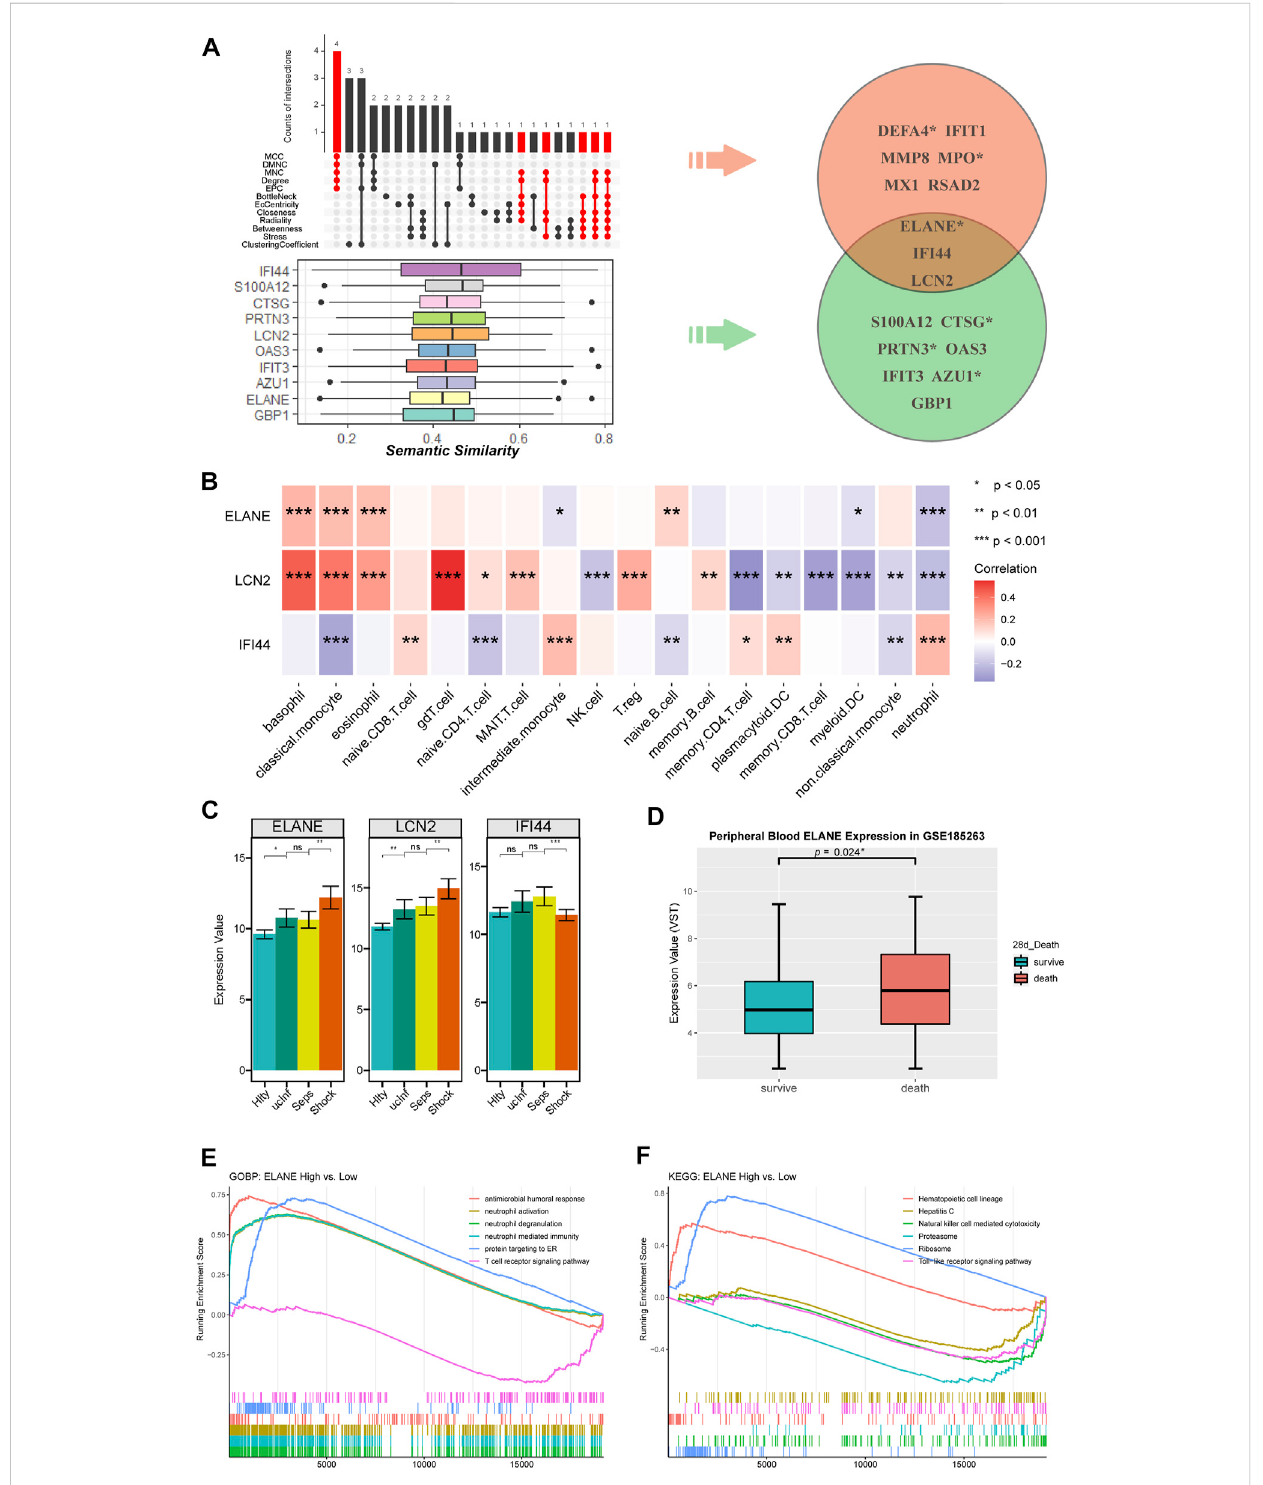
Theidenti fi cationofhubgenesinSSAGs. (A) Thegenesappearingatleast5timesintop10resultsofeachalgorithmusingcytoHubbawereextracted (marked in red) and shown in the upset plot, below the SSAGs with top 10 functional similarities estimated by Semantic similarity analysis were shown in boxplots.Threegeneswereidenti fi edashubgenesbyoverlappingthetworesults.Thegenenamesmarkedwithanasteriskindicatedthemasprognostic genes. (B) Correlations between hub genes and immune cell fractions. (C) Expression values of hub genes among the course from healthy to septic shock. (D) ELANEwassigni fi cantlyupregulatedindeath(n=52)vs.survival(n=293)groupoftheGSE185263dataset. (E) Biologicalprocessesenrichedin ELANE-high group. (F) KEGG pathways enriched in ELANE-high